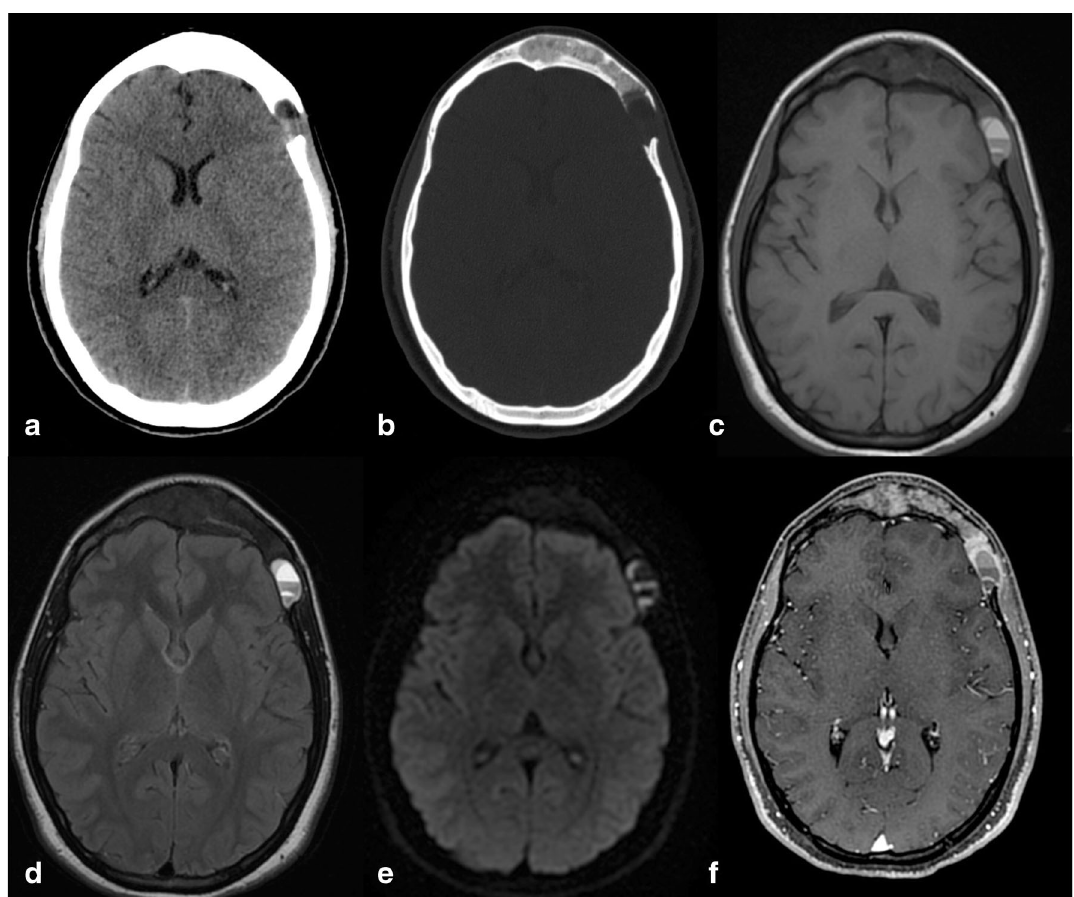
examination better depicts the multiloculated lesion, confirming blood- fluid levels on T1w ( c ), FLAIR ( d ) and DWI ( e ) images, and showing enhancement of the capsule and internal septa ( f )